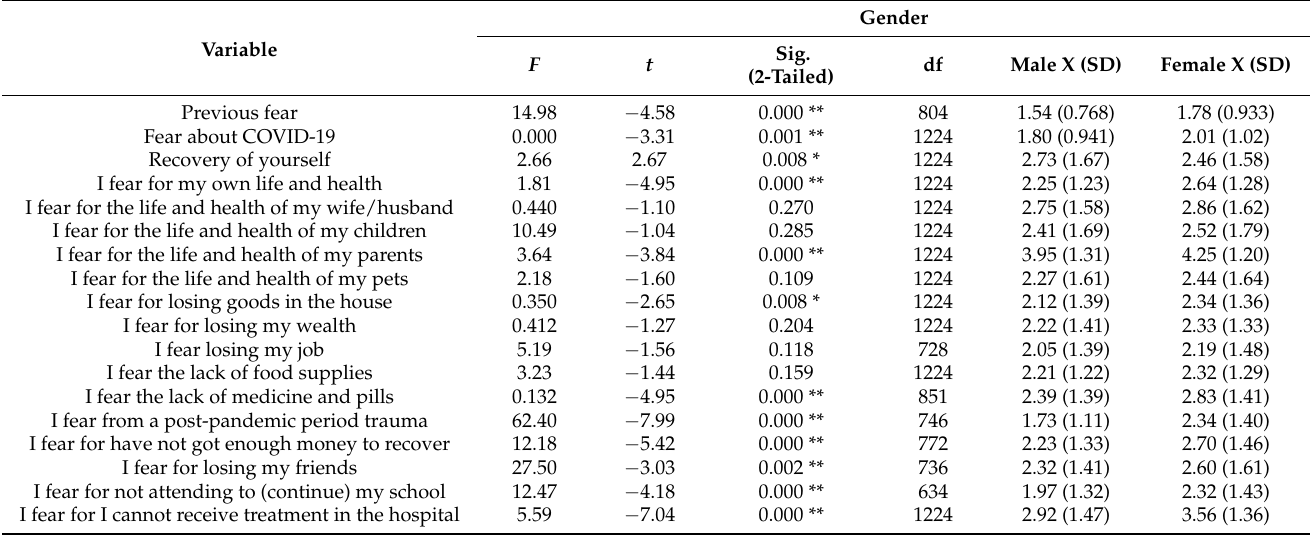
Table 7. Independent samples t -test results for gender and variables relating to fear caused by COVID-19.